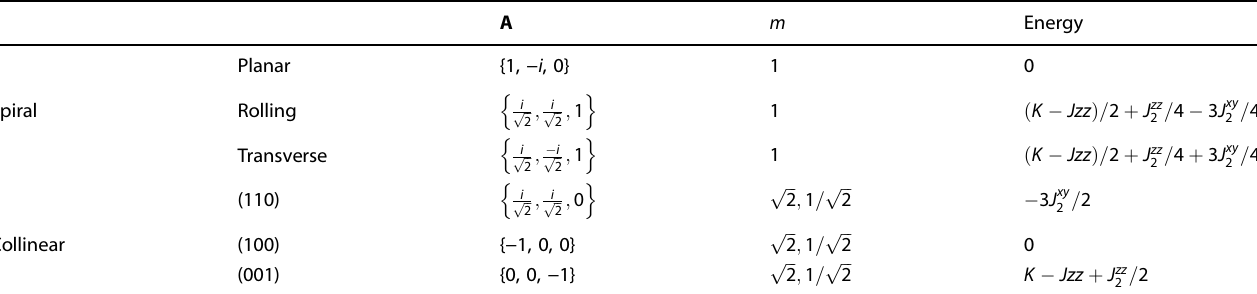
Table 3. Energies of various calculated magnetic states and the corresponding coef fi cients in Eq. (7). Magnetic moments are described